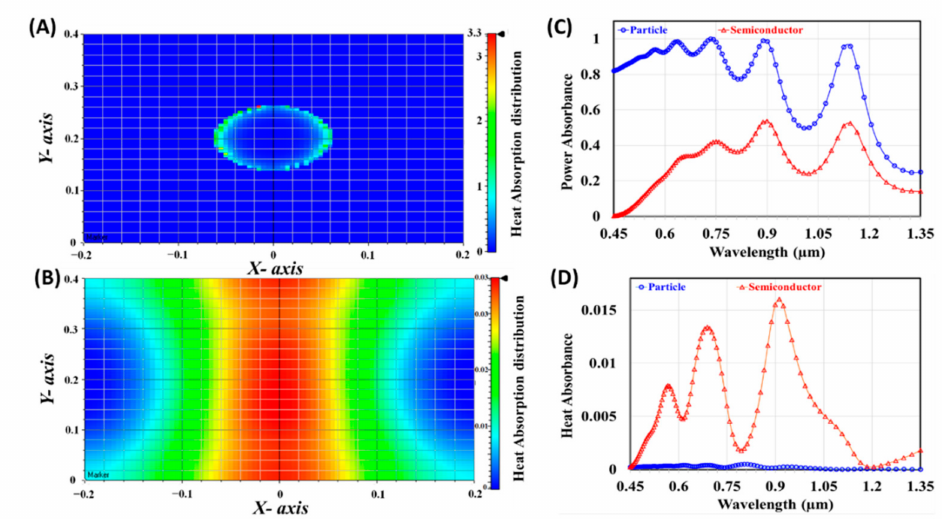
Figure 7. The heat absorption distribution at the center of ( A ) metallic plasmonic layer and ( B ) active semiconductor layer. The ( C ) power and ( D ) heat absorbance spectra at center of both plasmonic and active semiconductor